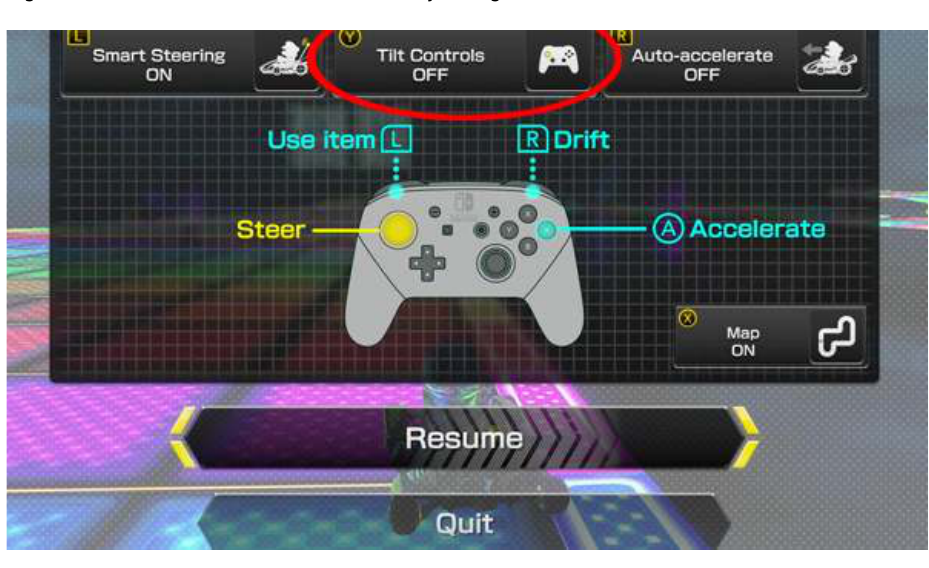
Figure 4: Screenshot of Mario Kart 8: Game Play in English